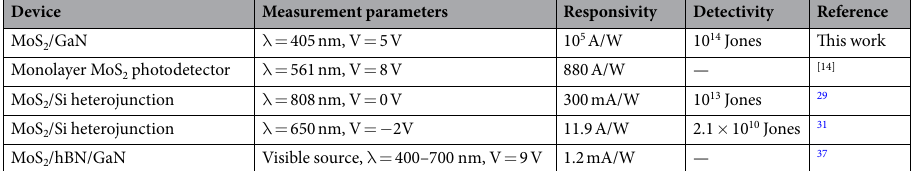
Table 1. Performance comparison of our MoS 2 /GaN heterojunction based photodetector with other MoS 2 based